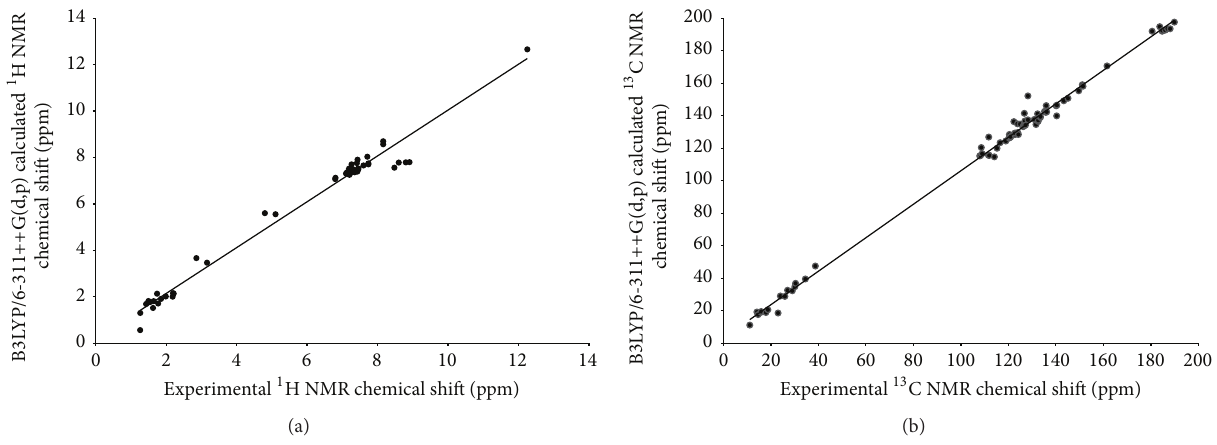
Figure 3: Linear regression between experimental and calculated B3LYP/6-311++G(d,p): (a) 1 H NMR chemical shifts and (b) 13 C NMR chemical shifts for the indolylquinones obtained in this